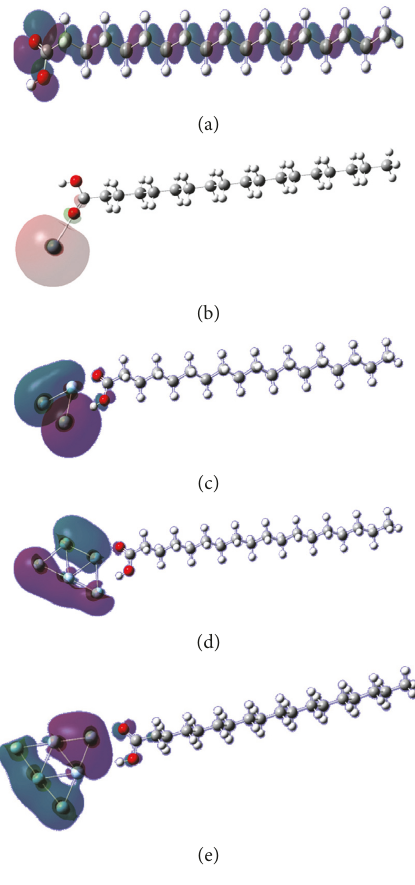
Figure 9: HOMO surfaces of (a) stearic acid and the complex between stearic acid with (b) a single silver atom, (c) cluster of 3 silver atoms, (d) cluster of 5 silver atoms, and (e) cluster of 6 silver